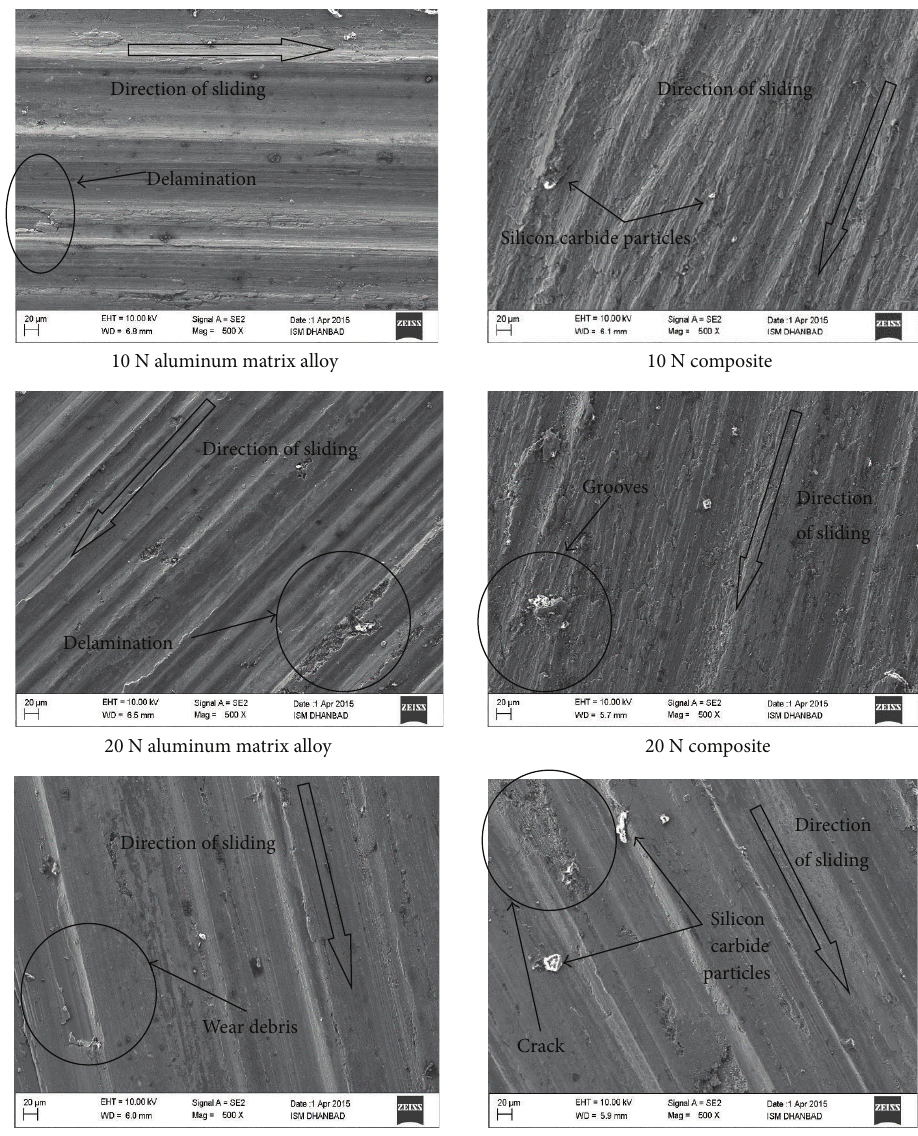
Figure 7: FESEM of worn surfaces at different loads with sliding speeds 3.14 m/s under lubricated